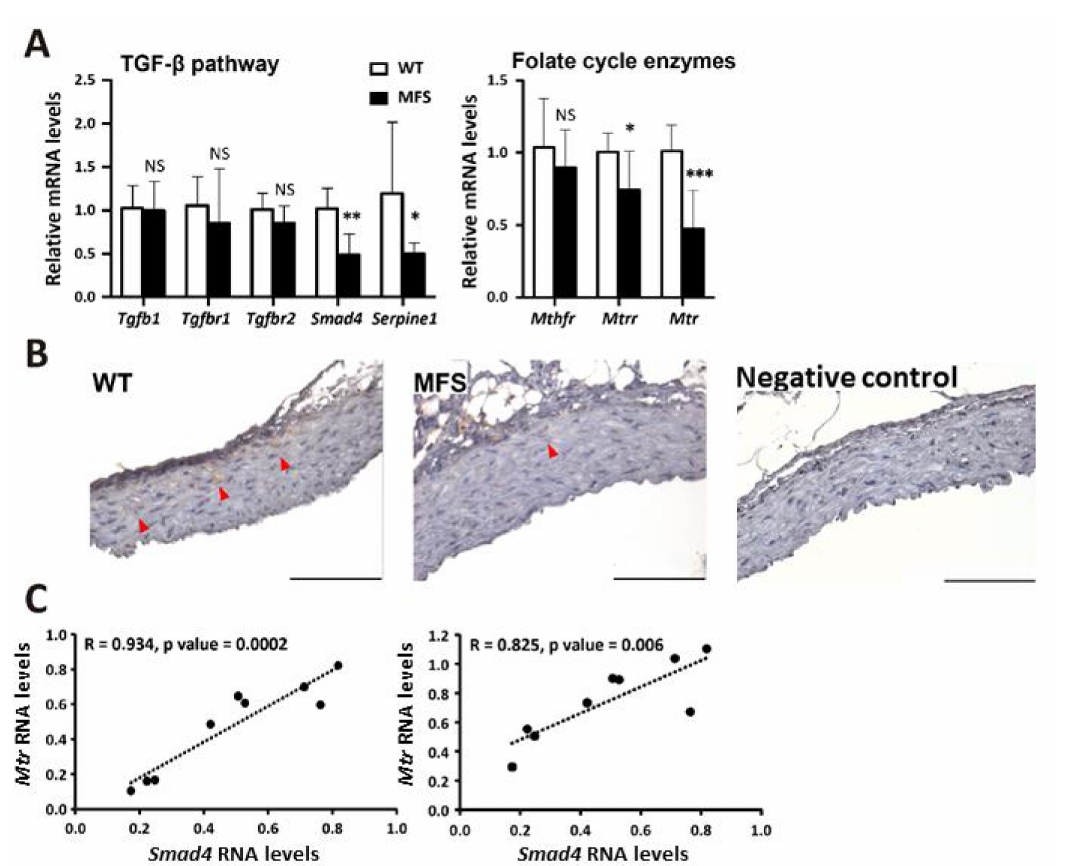
Figure 1. Positive correlation between insufficient Smad4, Mtr, and Mtrr RNA expression in 6-month-old MFS ascending aortas. ( A ) Real-time qPCR analysis of genes involved in the TGF- β pathway and the folate cycle metabolism in aortic tissues with adventitia removed (WT, n = 6; MFS, n = 9). ( B ) Smad4 immunostaining of proximal ascending aorta. Scale bar, 100 µ m. ( C ) Positive correlation between Smad4, Mtr, and Mtrr RNA expression of MFS aortic tissue ( n = 9). Data are presented as the mean ± SD. NS, no significant difference. * p < 0.05, ** p < 0.01, *** p <